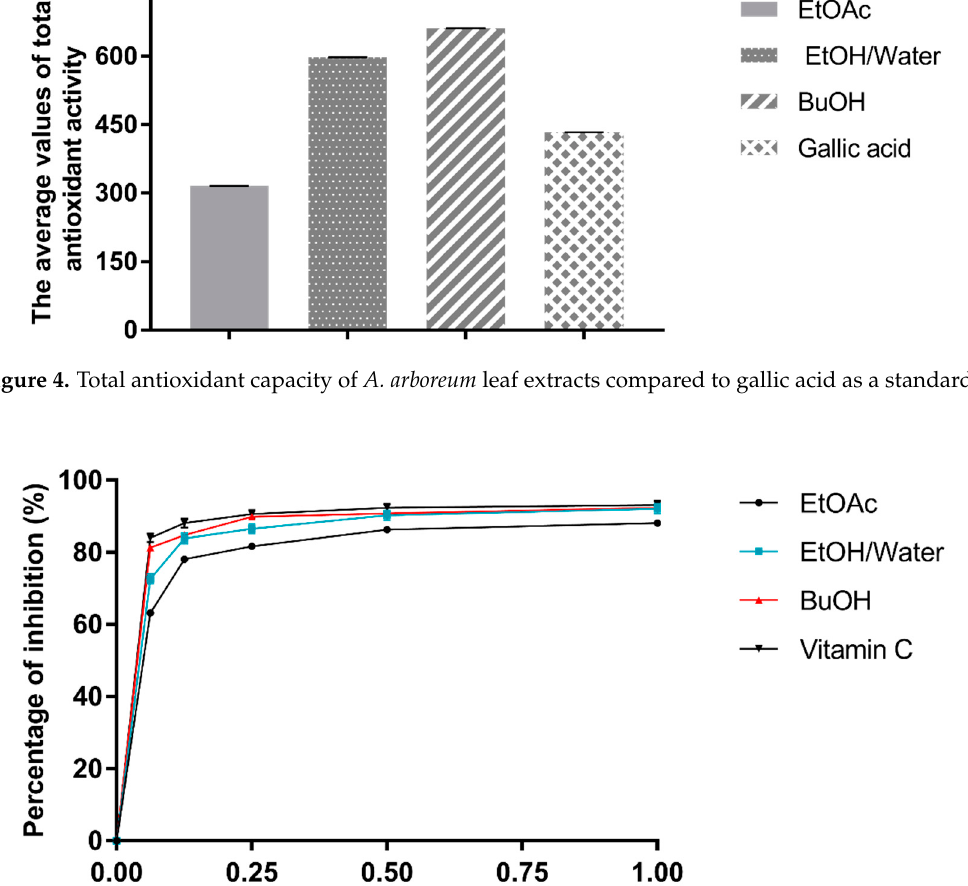
Figure 5. Scavenging activity of DPPH • radical assay of A. arboreum leaf extracts at different concentrations compared to